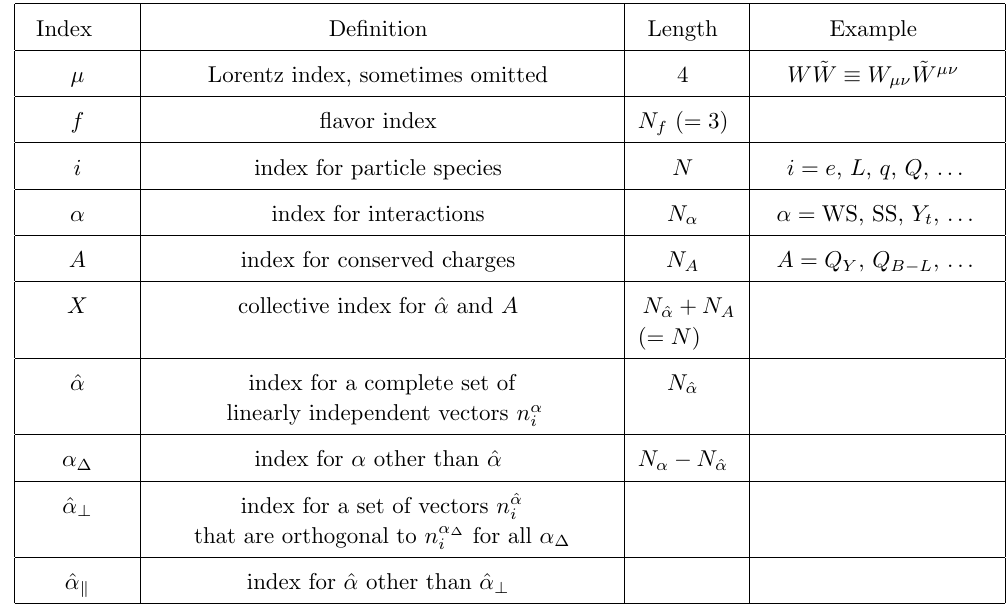
Table 3 . De(cid:12)nitions of